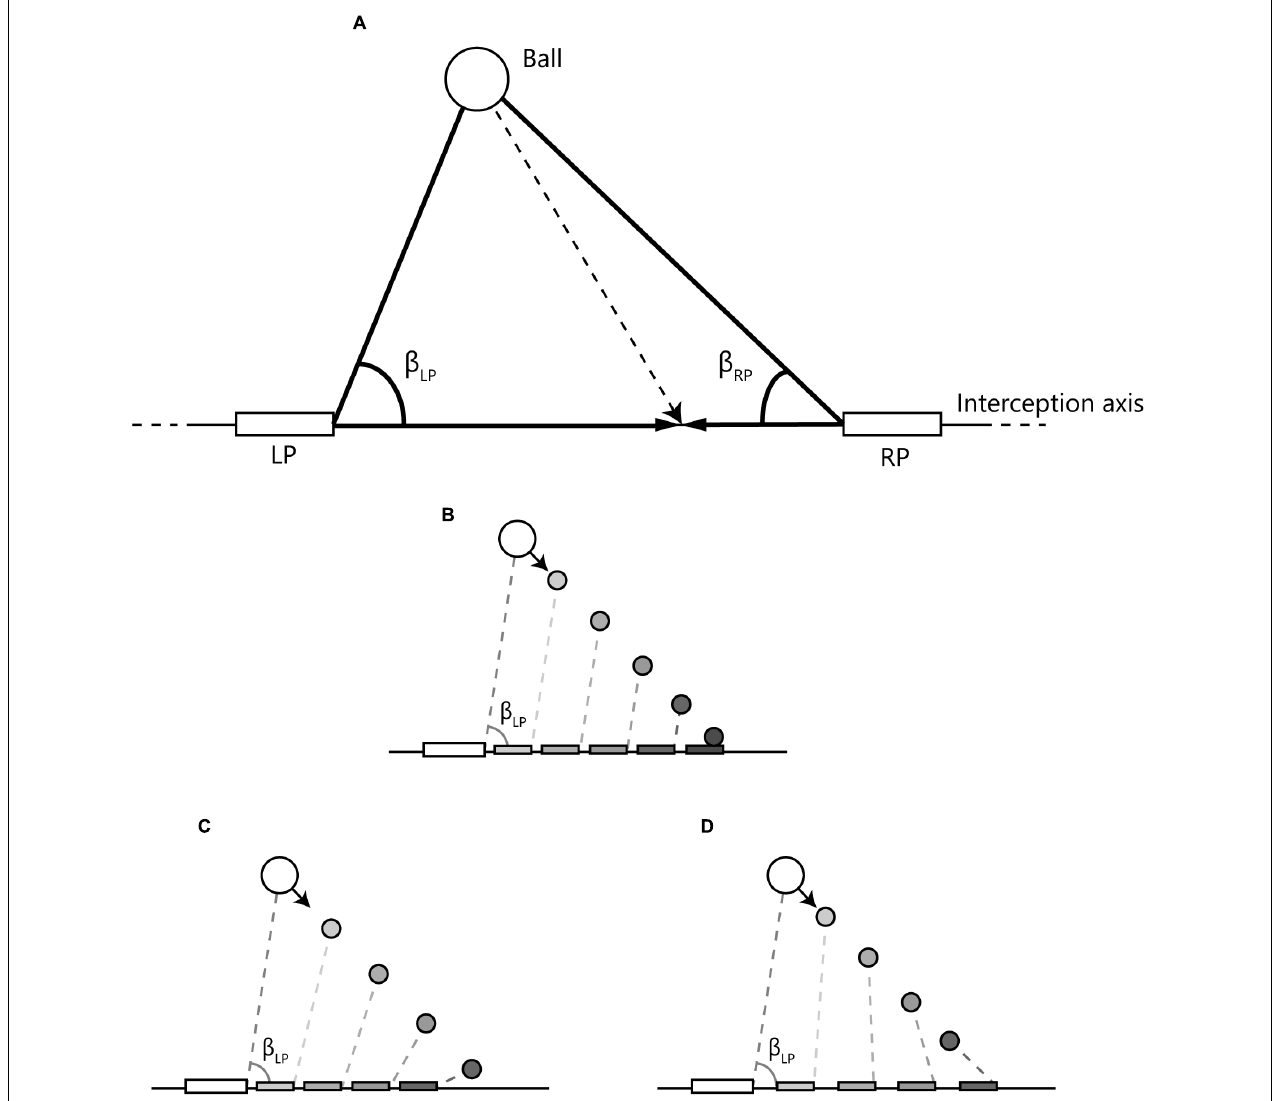
FIGURE 3 | Definition and time course examples of angles used to capture the relations between the paddles and the ball. (A) LP and RP represent the paddles of the left and right participant, respectively, that could freely move along the interception axis. β LP and β RP are the angles formed by the line connecting both paddles and the lines connecting each paddle with the ball. (B) When the (left) paddle moves at a speed that will bring it to reach the ball arrival position when the ball (moving at constant velocity) gets there, β LP is constant over time (i.e., AV is zero). (C) When the paddle moves at a lower speed, β LP closes (decreases) over time (i.e., AV is negative). (D) When the paddle moves at a higher speed, β LP opens (increases) over time (i.e., AV is